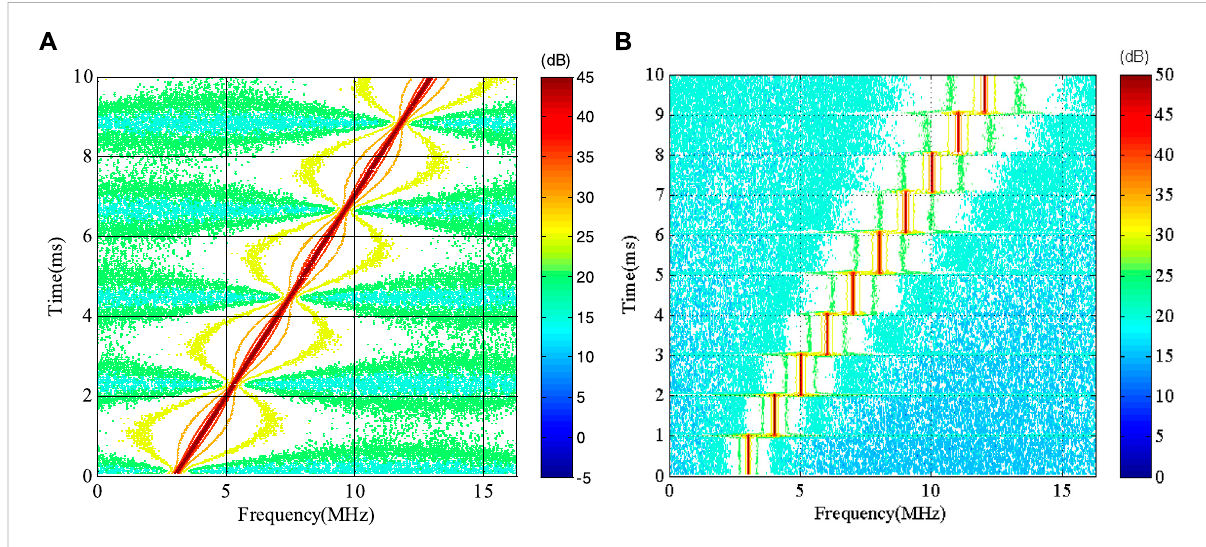
FIGURE 7 Time-frequency domain characteristics of sweeping-frequency interference. (A) CFM (B) DFM.